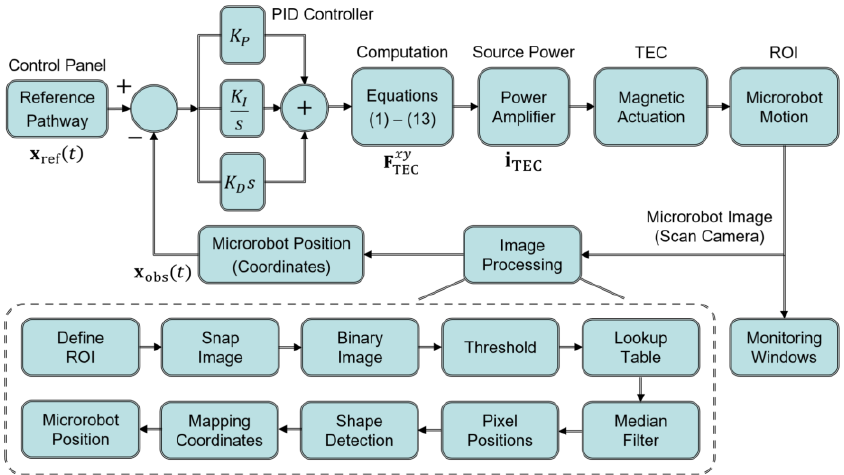
Figure 3. Schematic diagram of the closed-loop control system implemented to the experimental setup shown in Figure 2. The system also includes a real-time image processing procedure using a LabVIEW visual object tracking system. Observed positions of the microrobot may be different from its real positions because of the limitations of the scan camera’s optical resolution and the computational errors during the image